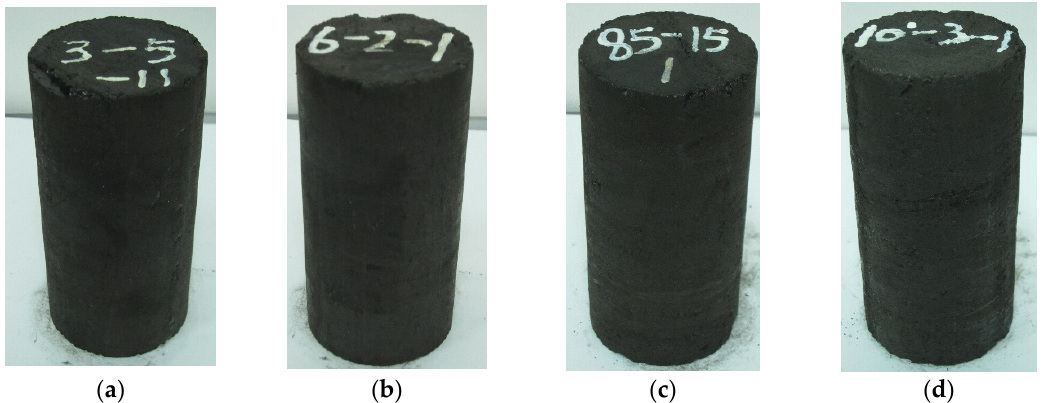
Figure 1. Typical coal samples prepared at different depths: ( a ) 300 m, ( b ) 600 m, ( c ) 850 m, and ( d ) 1050 m.